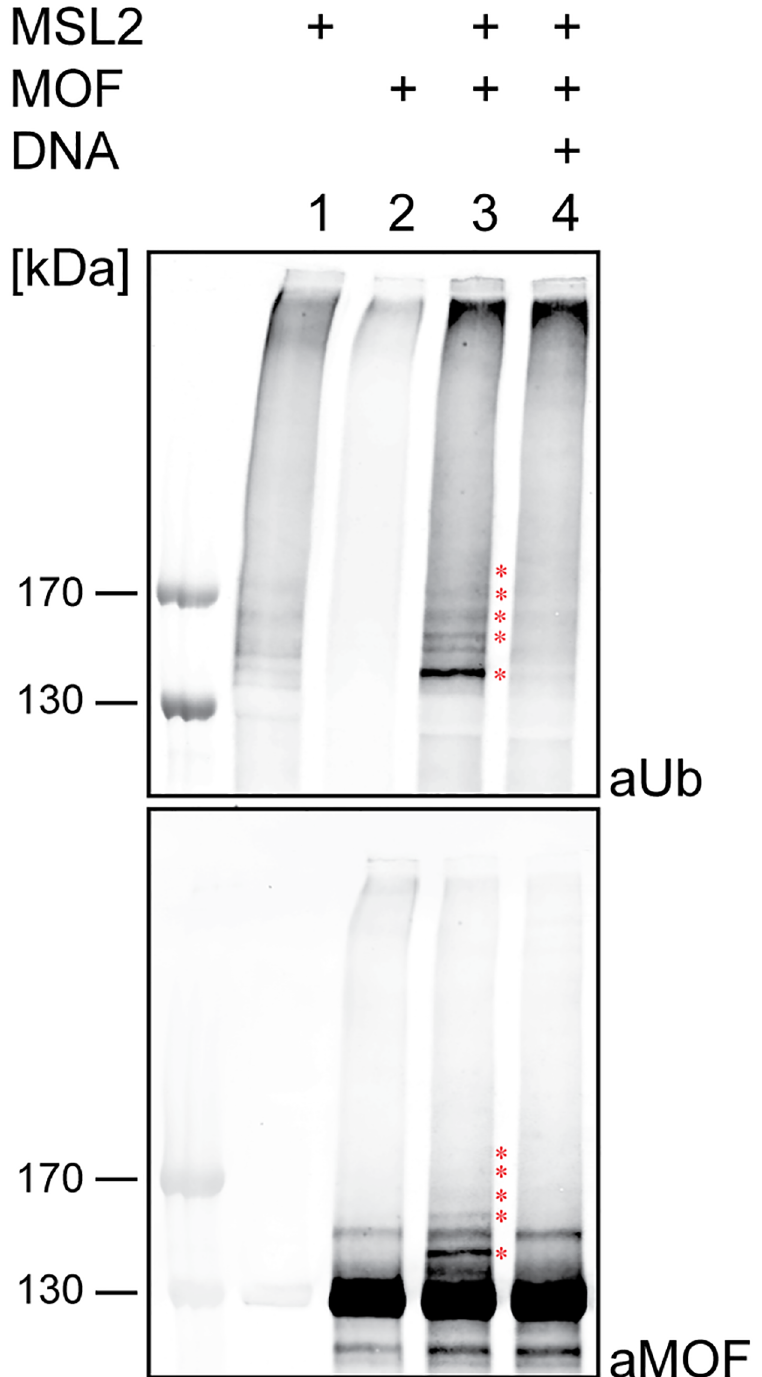
Fig 5. MSL2-mediated MOF ubiquitylation in vitro is inhibited by DNA. In vitro ubiquitylationassays in presenceof DNA. Assays were performed as describedin Fig 1C. A saturating amount of DNA (1 μ M) was added to the reactionsas indicated. Ubiquitylated proteins were detected using antibodiesagainst ubiquitin (aUb) and MOF (aMOF). Protein size markers (kDa) are indicatedto the left. The experiment was repeated3 times with similar